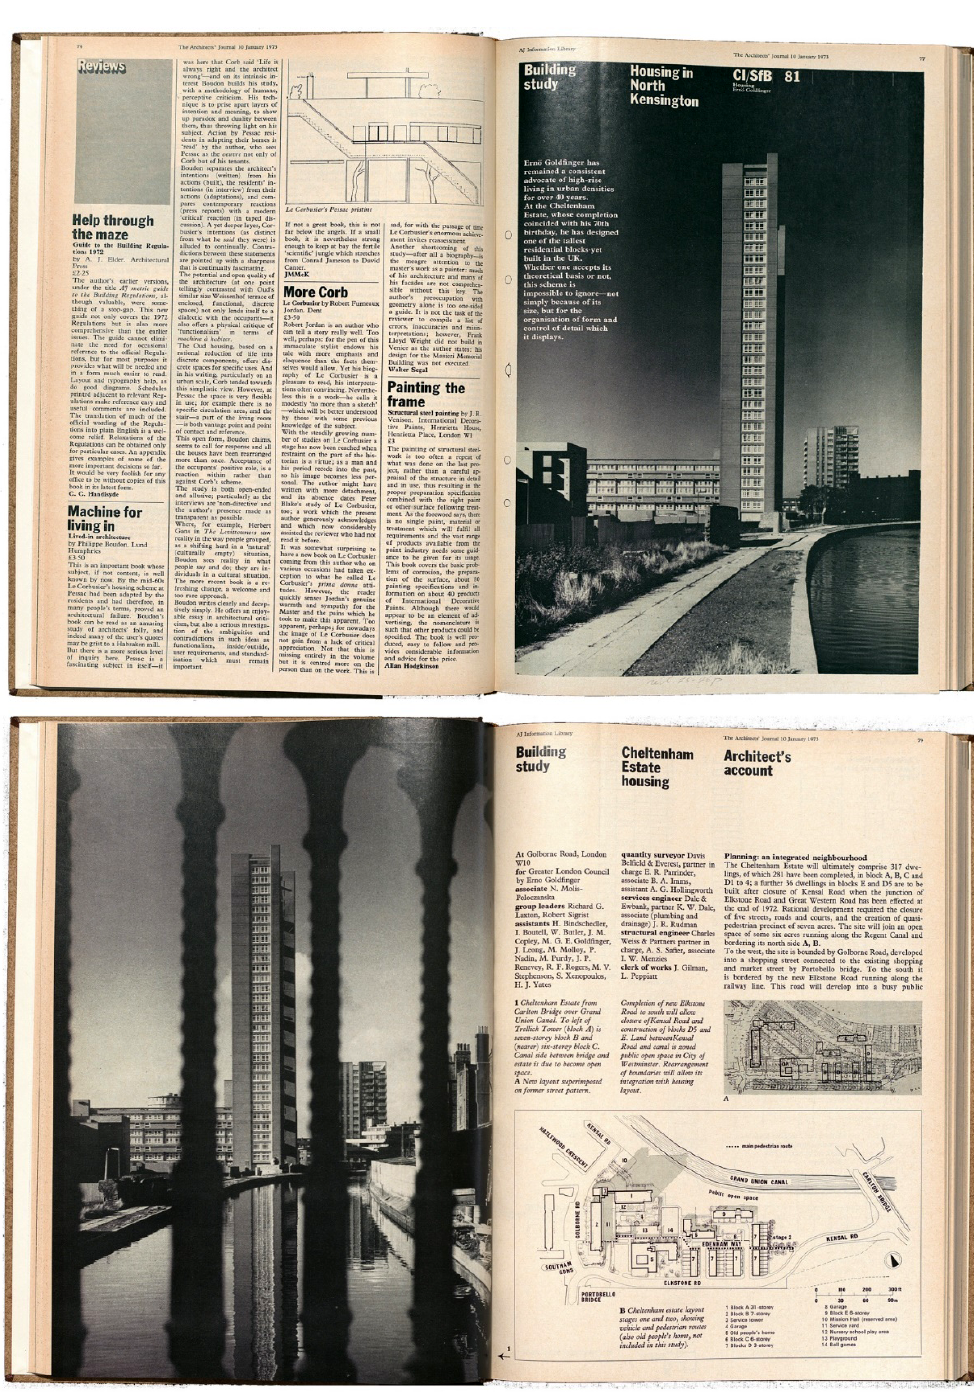
Figure 10. Richardson M. (1973). Cheltenham Estate housing, Architects’ Journal , 157